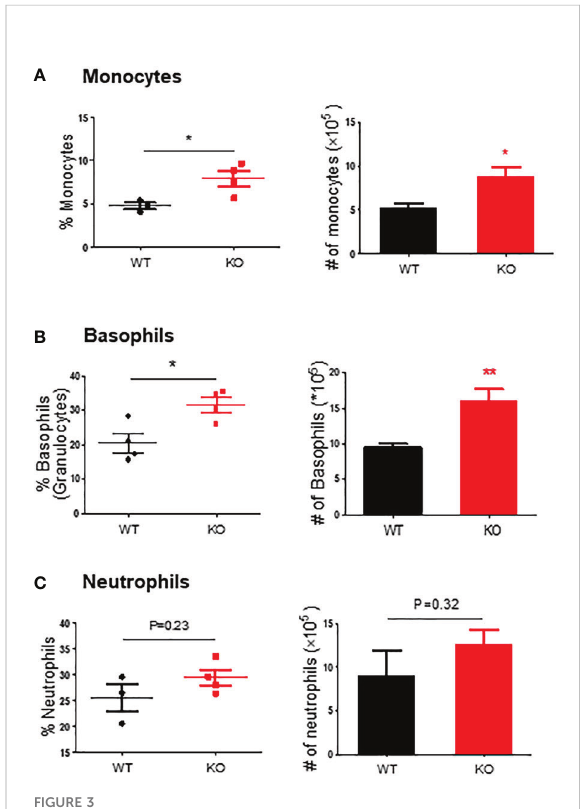
FIGURE 3 Monocytes, basophils, and neutrophils in the spleen of mice exposed to DSS. Flow cytometry was used to assess monocytes (SSC-A high CD45 + Ly6C + Ly6G - ) (A) , basophils (SSC-A high CD45 + c-Kit - FC ϵ RI + ) (B) , and neutrophils (SSC-A high CD45 + Ly6G + ) (C) in the spleen of mice exposed to DSS at 1.5%, as described in the Materials and Methods. Left panel , percentage; right panel , absolute number of cells. KO, knockout; WT, wild type. *p < 0,05; **p <